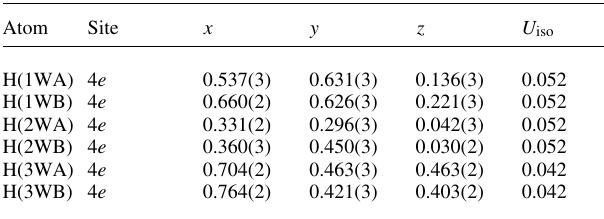
Table 2. Atomic coordinates and displacement parameters (in Å 2 )